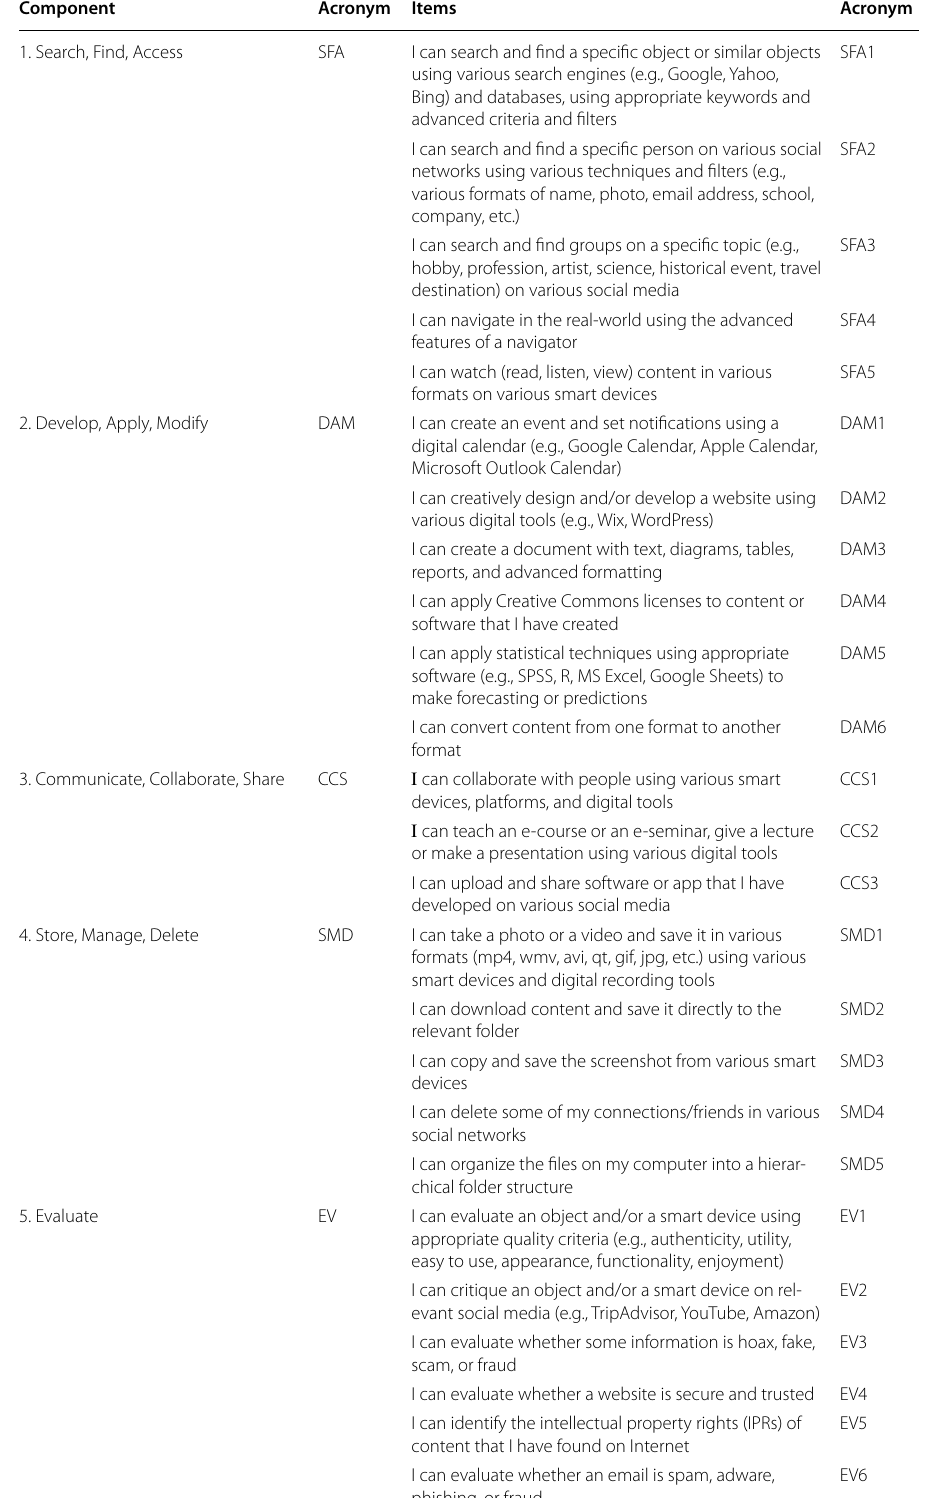
Table 7 SDiCoS instrument: components of the students’ digital competence scale (SDiCoS) and measured